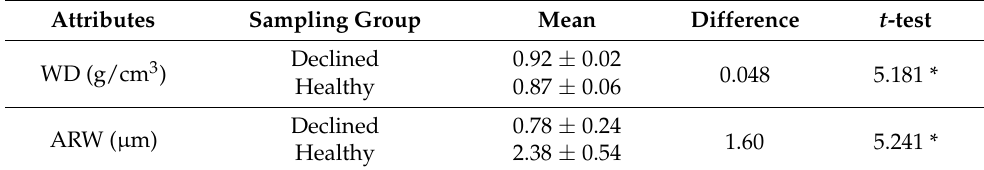
Figure 2. Wood density of declined (D1–D3) and healthy trees (H1–H3) of Quercus brantii in three areas of the Iranian forest: Dareh shahr, Sheshdar and Chavar. Density was measured in the wood samples from near-pith towards near-bark. H: Healthy trees; D: Declined trees; 1: Area A; 2: Area B; 3: Area C; P: Near-pith; M: Middle; B: Near-bark) .